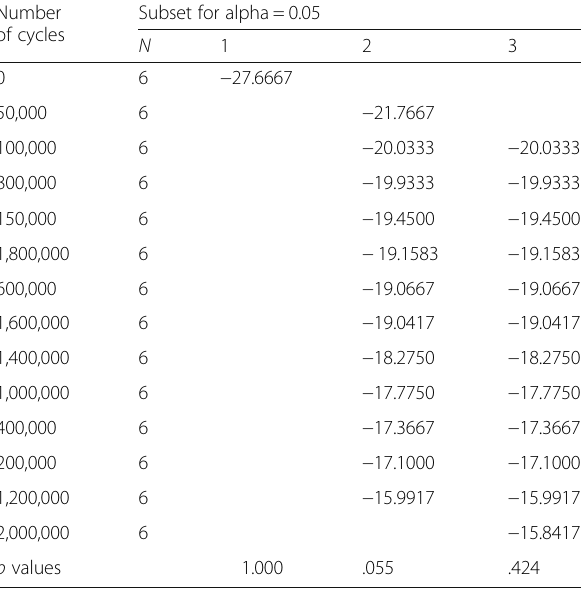
Table 3 Post hoc Tukey ’ s HSD test of mean removal torque values in all groups